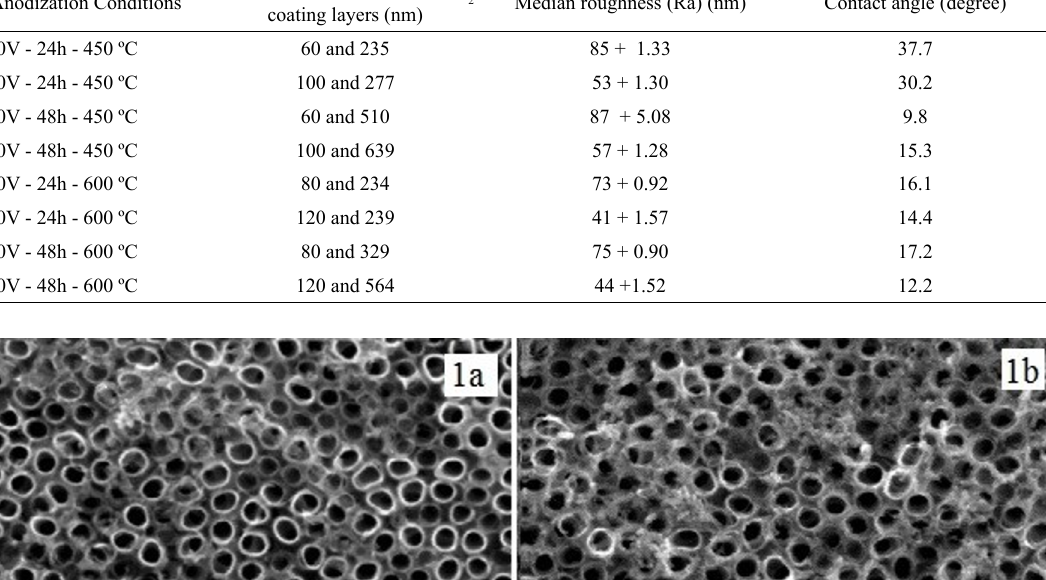
Table 1. Surface properties of anodized Ti-7.5Mo Anodization Conditions